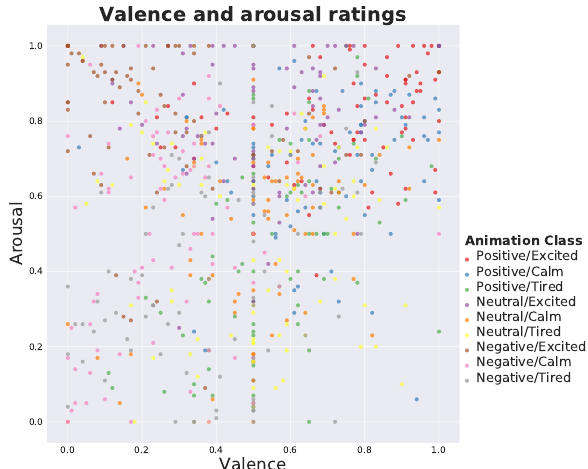
Figure 4: Valence and arousal ratings from all animations and raters color-coded according to the pre-assigned animation class.